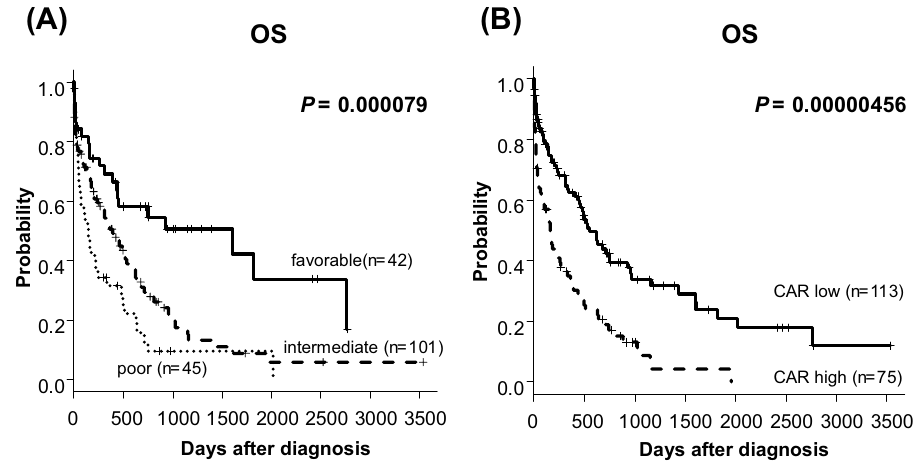
Figure 3. Kaplan–Meier plots of OS according to NCCN 2017 risk classification ( A ) and CAR ( B ).